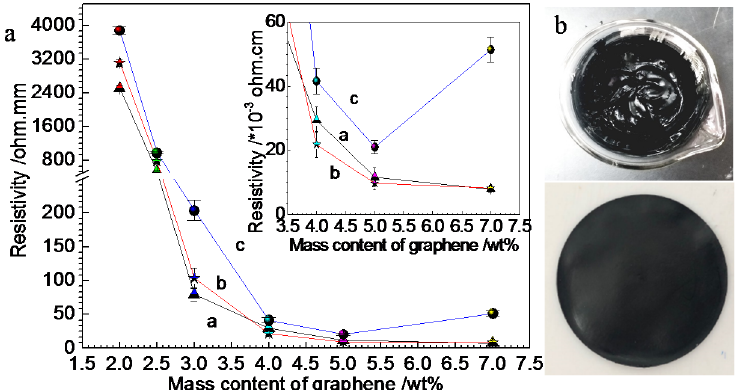
Figure 3. ( a ) Resistivities of RGO/NCC-TPU composite films with different mass contents of reduced graphene oxide (RGO) and TPU initial concentrations of 10 wt% (curve a), 20 wt% (curve b), and 30 wt% (curve c), respectively, and ( b ) photos of RGO/NCC-TPU slurry prepared with TPU initial concentrations of 20 wt% and 5 wt% RGO (above) and corresponding RGO/NCC-TPU composite film (below), respectively. The inset in Figure 3a is local magnification.